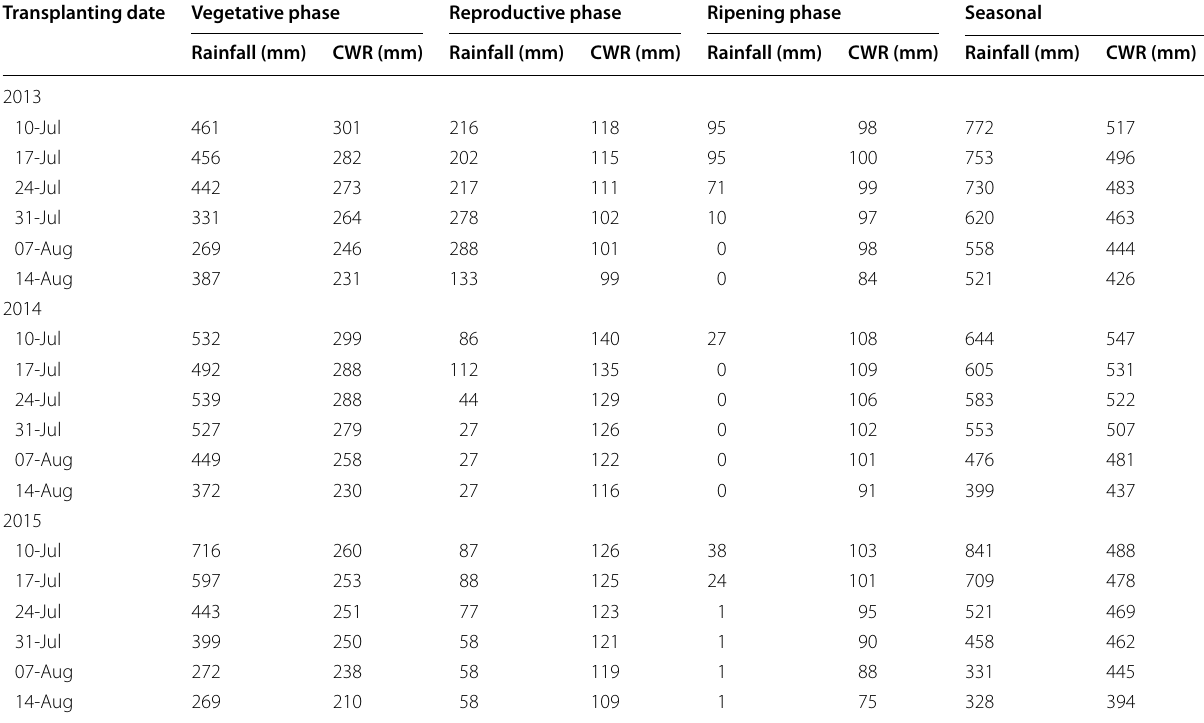
Table 1 Rainfall and crop water requirement (CWR) amount at different growth phase under varying transplanting dates during